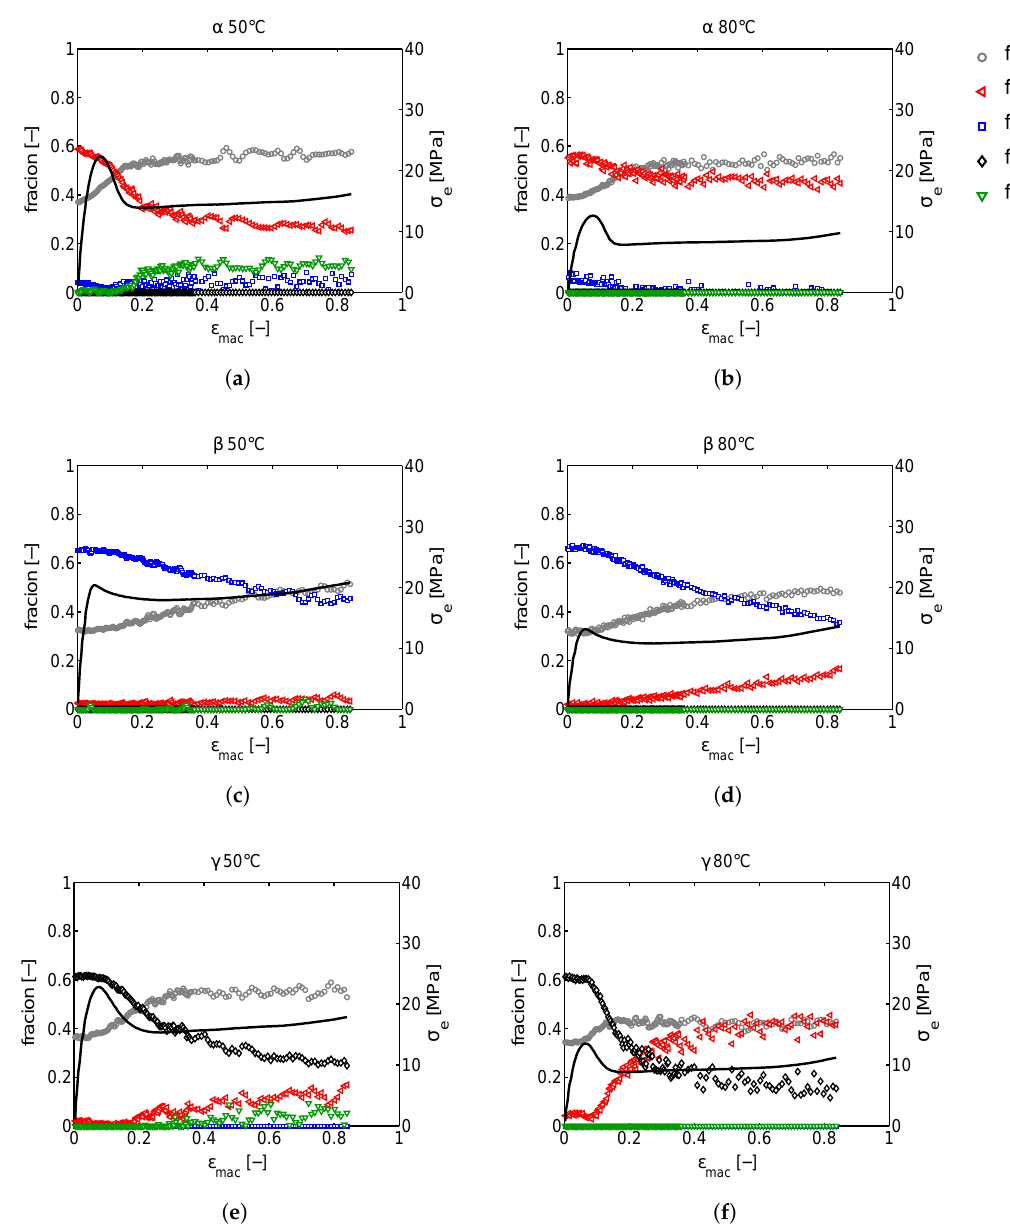
Figure A1. The crystal phase fractions obtained from the WAXD experiments. In ( a , c , e ), we see the evolution of the crystallinity and phase fractions upon stretching at 50 ◦ C. Figure ( b , d , f ) show the result of the tensile experiments performed at 80 ◦ C. From top to bottom, we see α , β and γ